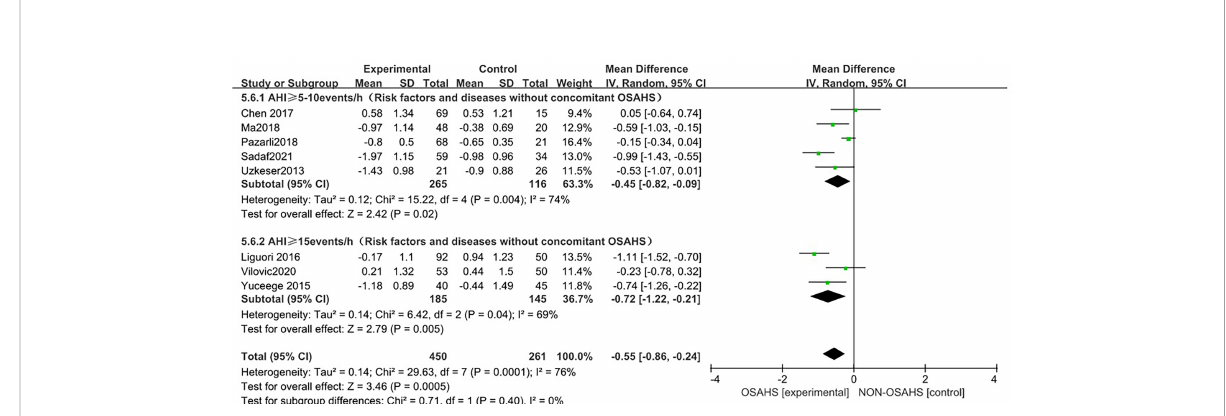
FIGURE 9 Forest plot of lumbar spine T-score “ AHI grouping ” subgroup analysis between OSAHS group and control group (grouped according to OSAHS diagnostic criteria, after exclusion of osteoporosis-related risk